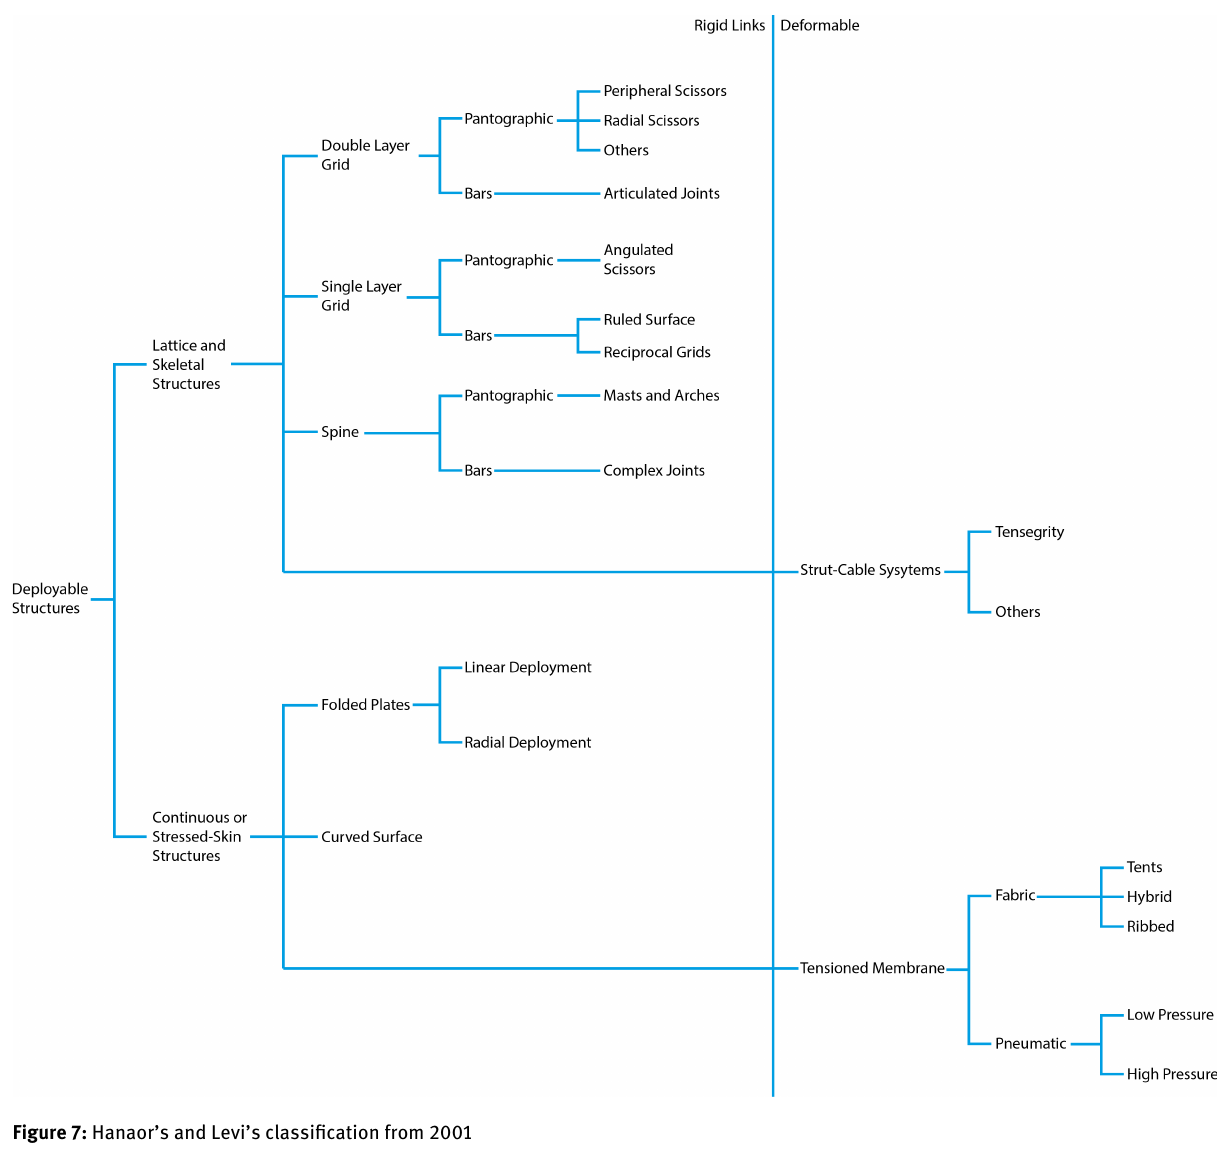
Figure 7: Hanaor’s and Levi’s classification from 2001